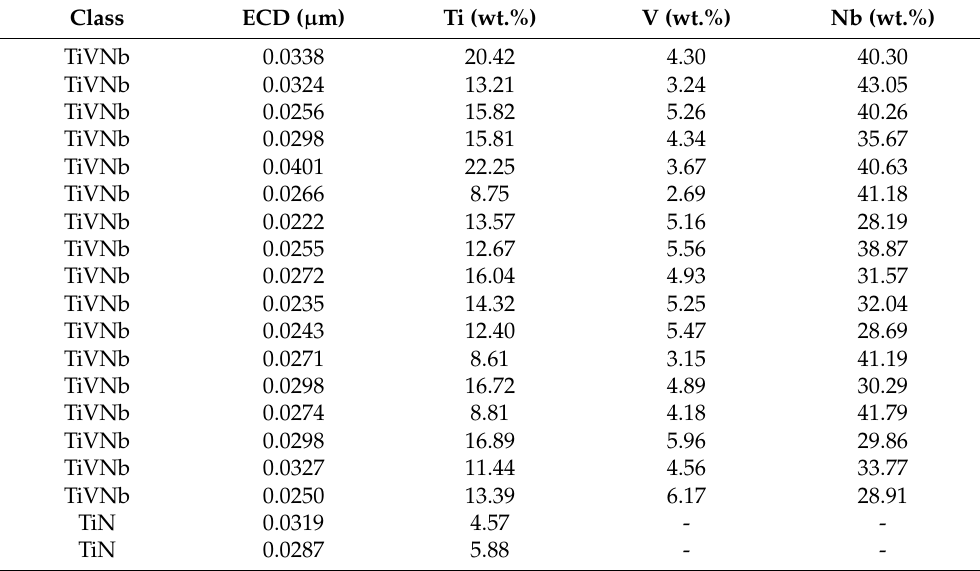
Table 3. Measurement of size and the corresponding element contents for each particle in Figure 2b